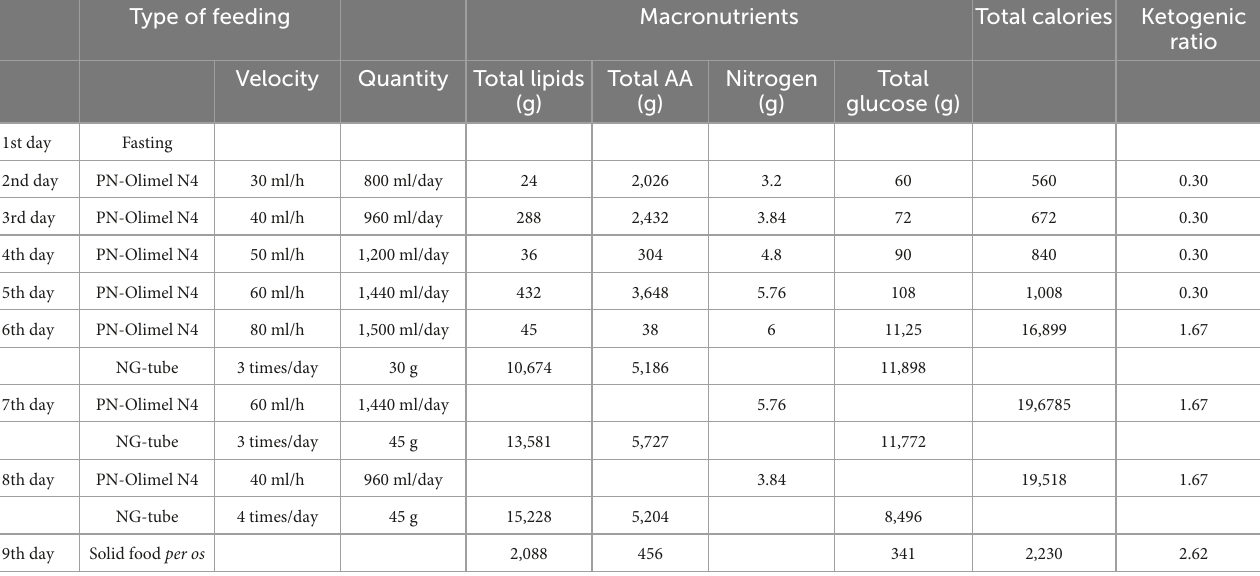
TABLE 1 Timeline of Practical plan of Parenteral and Enteral Nutrition (PEN) management. Type of feeding